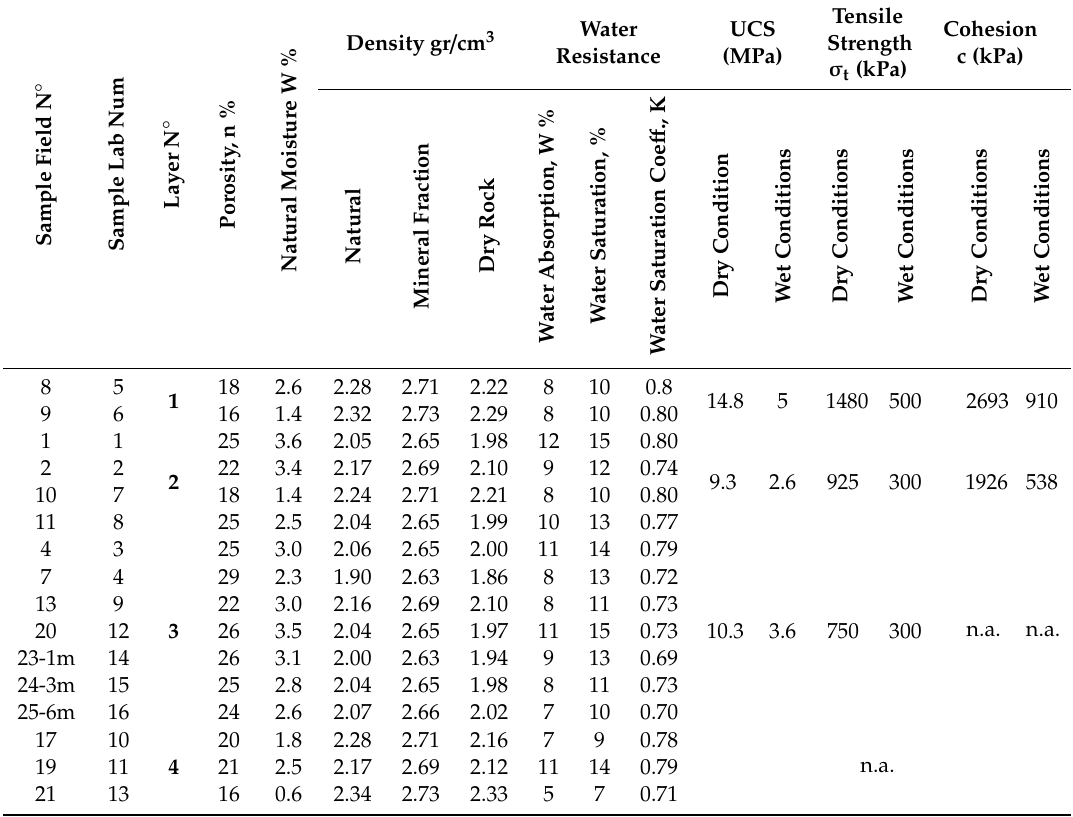
Table 2. Laboratory analyses performed on the collected Vardzia